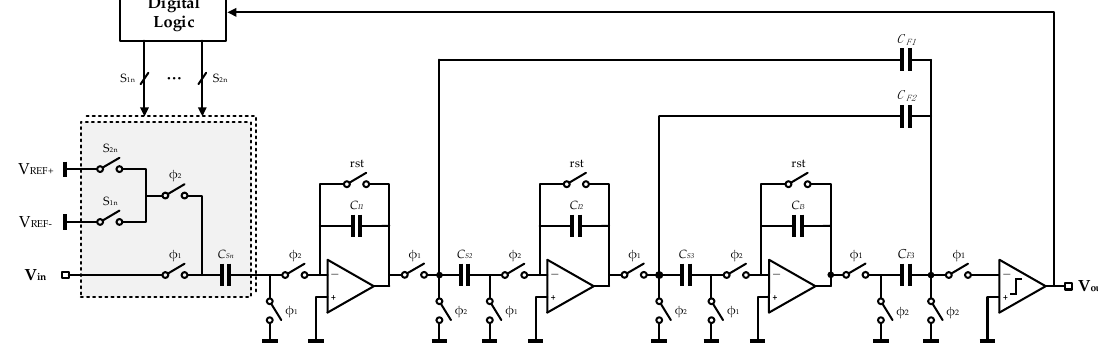
Figure 10. Simplified schematic of the implemented modulator.